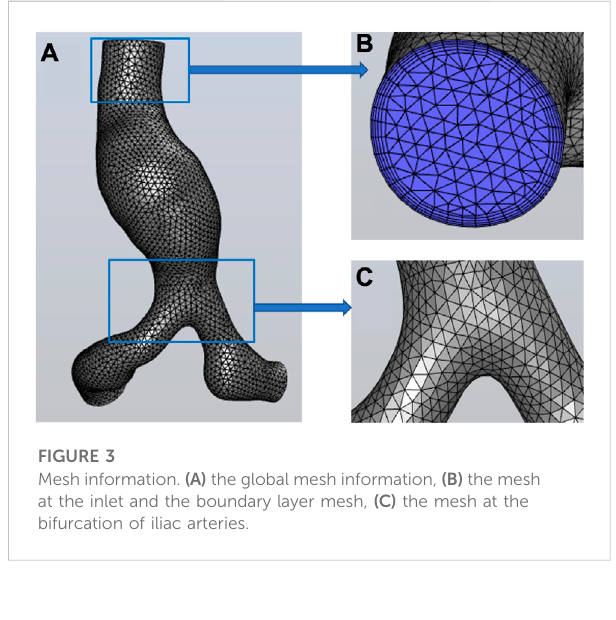
FIGURE 3 Mesh information. (A) the global mesh information, (B) the mesh at the inlet and the boundary layer mesh, (C) the mesh at the bifurcation of iliac arteries.